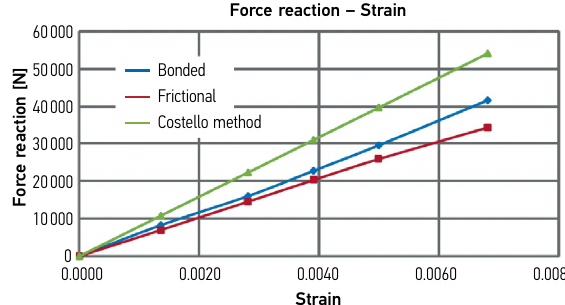
Fig. 14. Boundary conditions for 7 × 19 wire rope